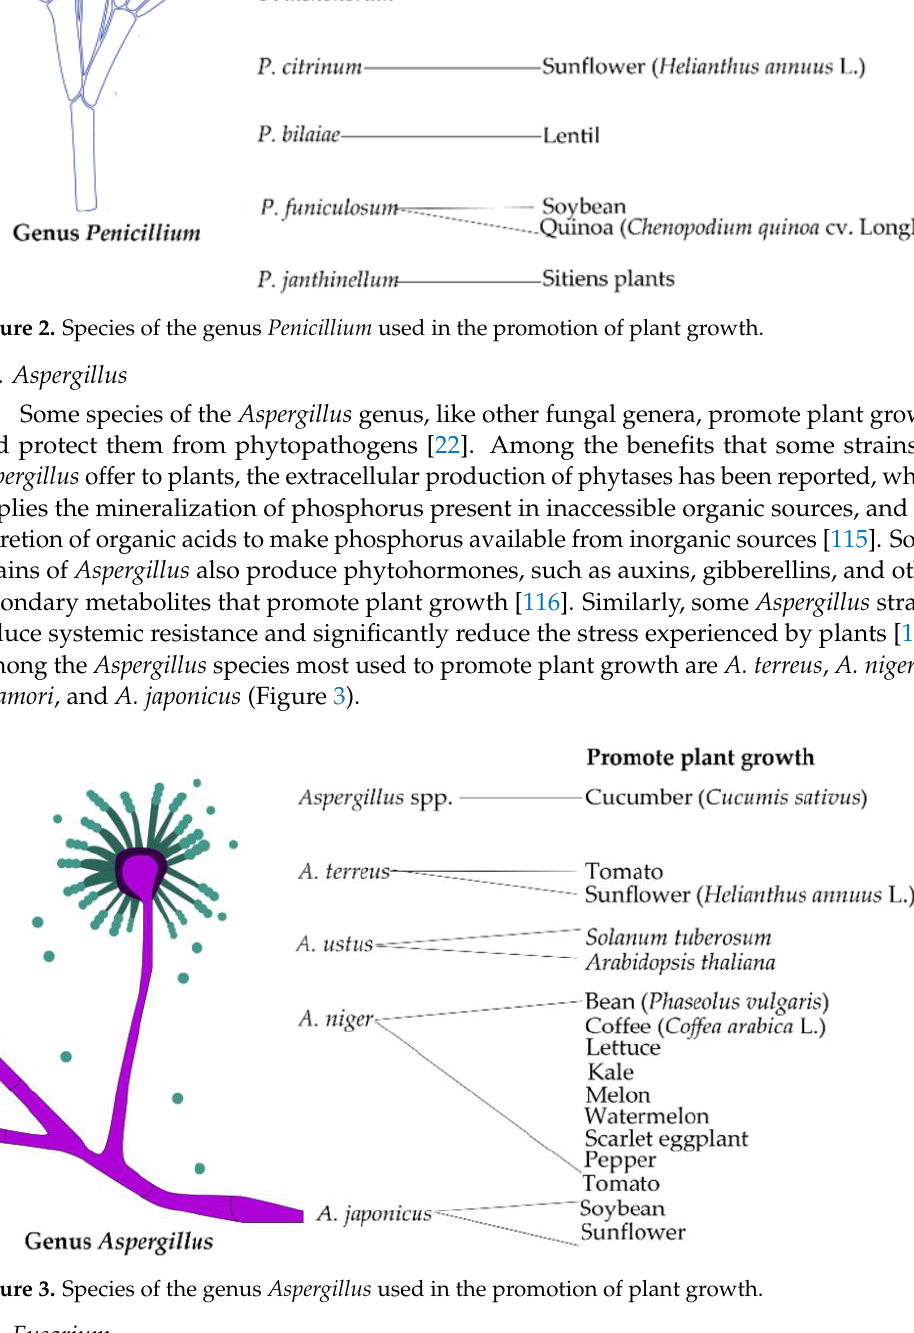
Figure 3. Species of the genus Aspergillus used in the promotion of plant growth.